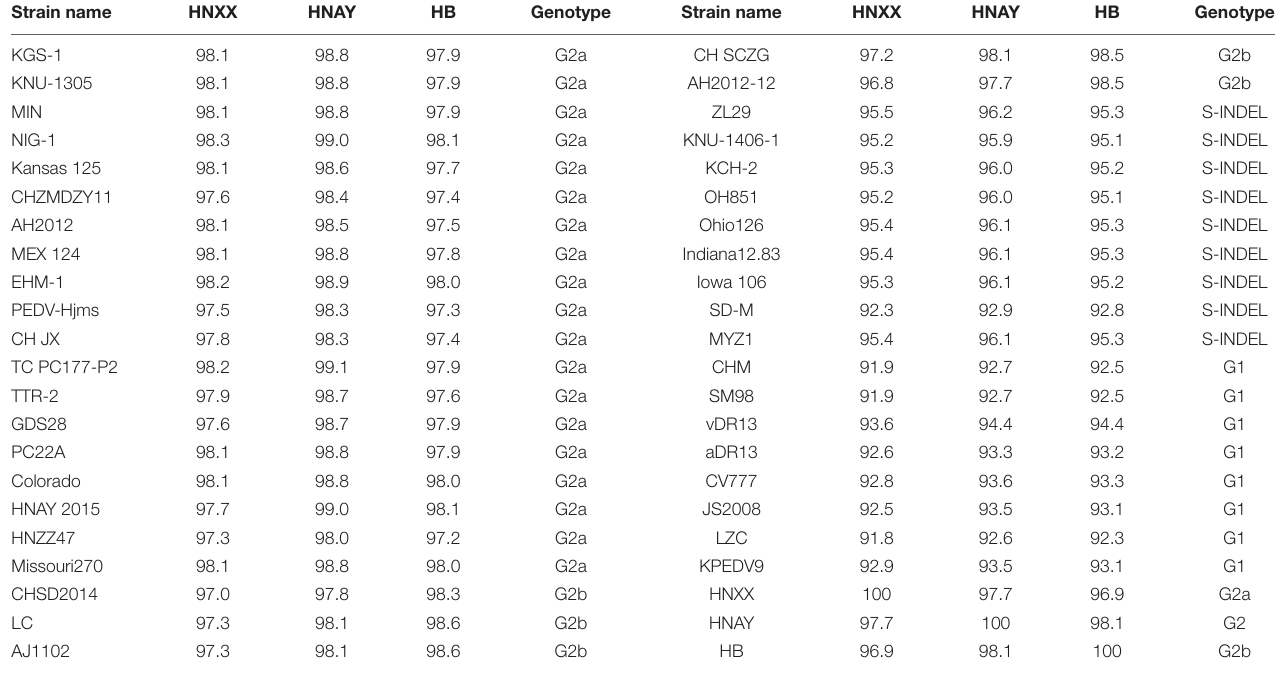
TABLE 4 | Amino acid identity (%) of S proteins of different PEDV